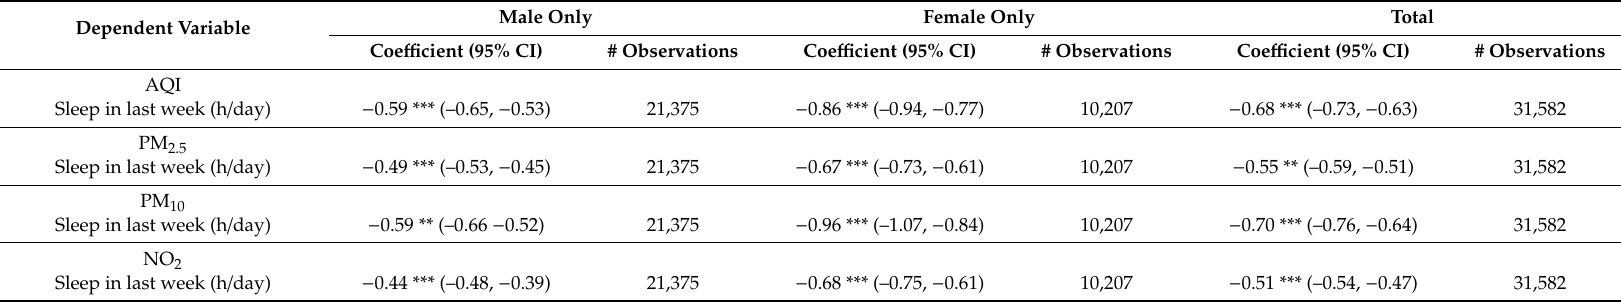
Table 4. Estimated e ff ects of air pollution on individual-level sleeping outcomes in the past week per day by